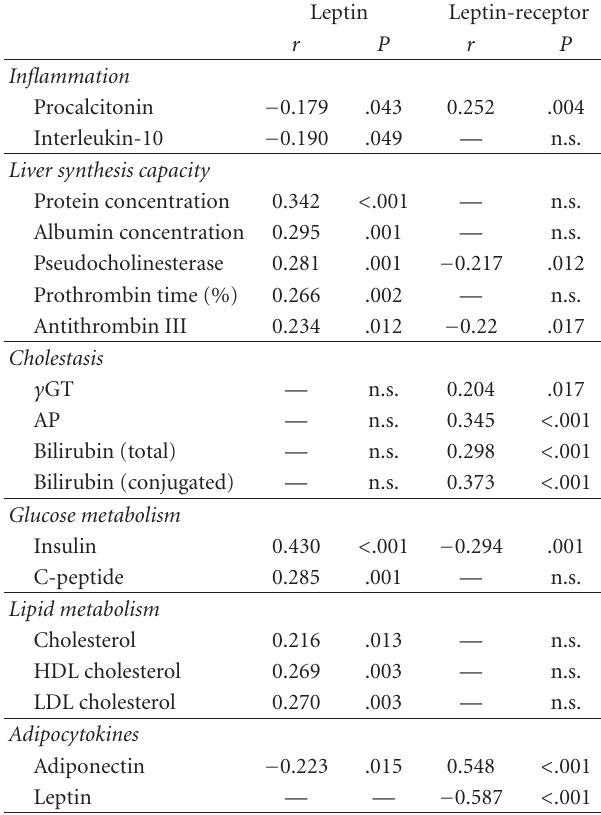
Table 2: Correlation